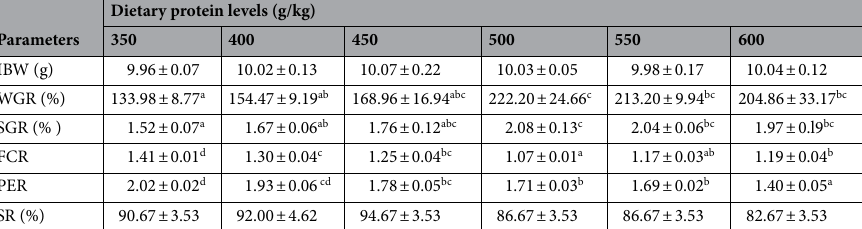
Table 1. Effect of dietary protein level on growth performance of juvenile orange-spotted grouper. Values in the table are means ± SD (n = 3). Values in the same line with different superscripts indicate significant